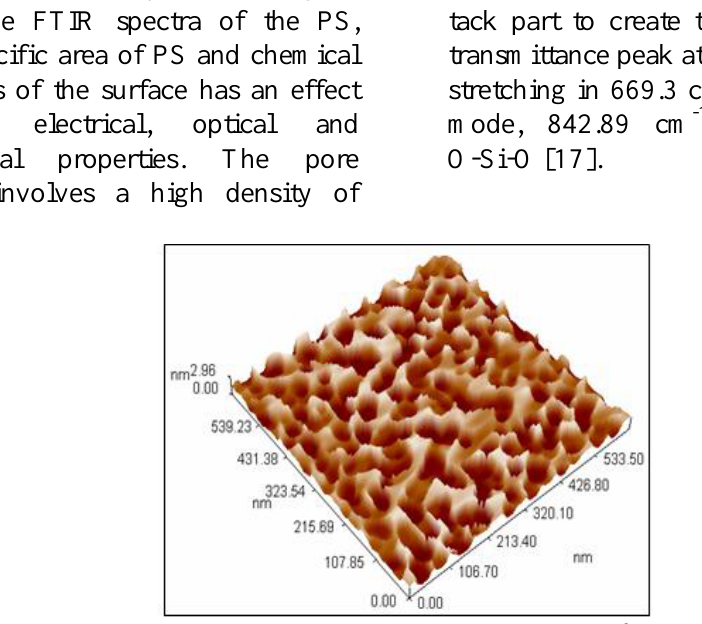
Fig. 3: 3D AFM image of PS layer at current density-15 mA/cm², etching time 15 min and